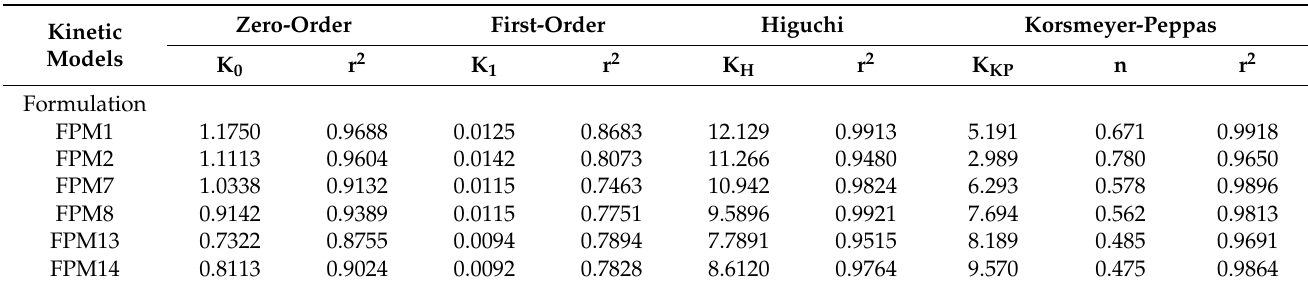
Table 4. Drug permeation over 60 min according to zero-order, first-order, Higuchi, and Korsmeyer- Peppas